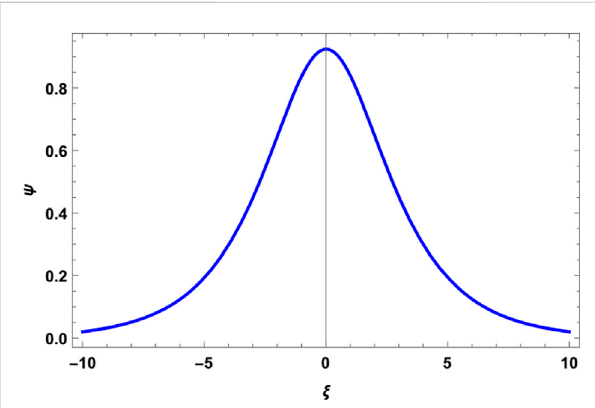
FIGURE 6 Soliton pro fi le for plasma parameters α =0.0, β =0.026, γ =0.7, δ =0.01, μ =0.25, ] =0.75, and m =1. Here, A > 0 and 2 m 2 − 1 > 0.